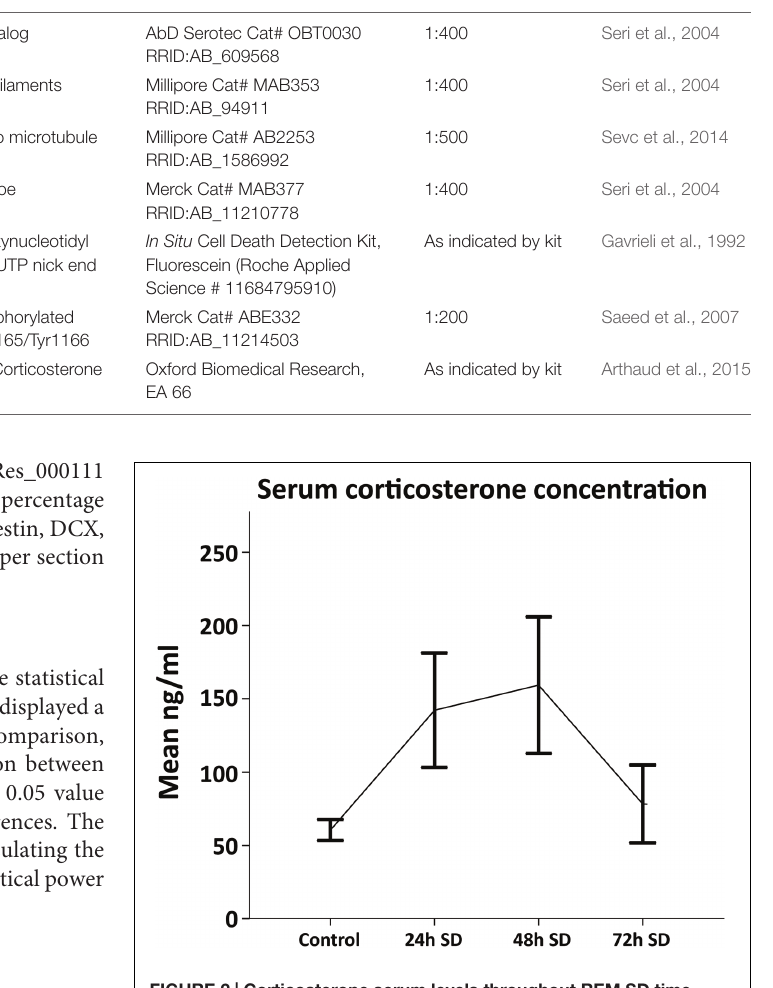
FIGURE 2 | Corticosterone serum levels throughout REM SD time course. The levels of corticosterone concentration (mean ± SE) were increased by 24-h and 48-h as compared to controls ( n = 3 per group). Although no significant differences were found amongst groups (Mann–Whitney “ U ”), the 72-h SD group showed corticosterone levels similar to the control